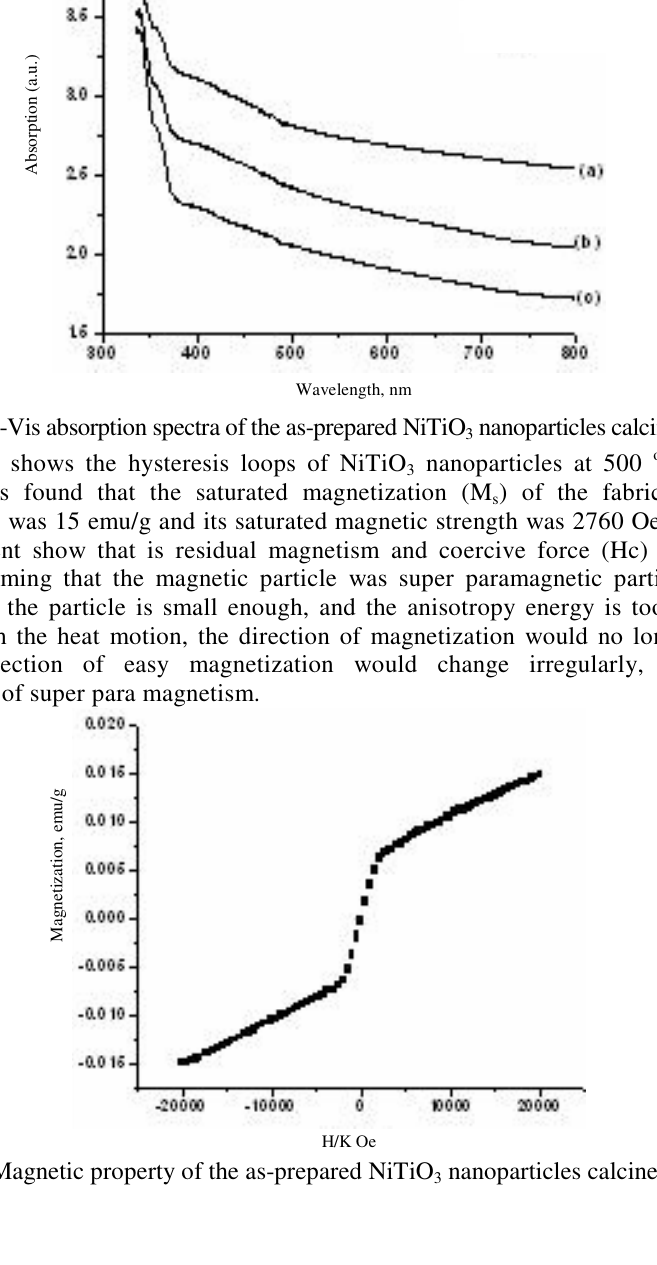
nanoparticles calcined at 500 o 3